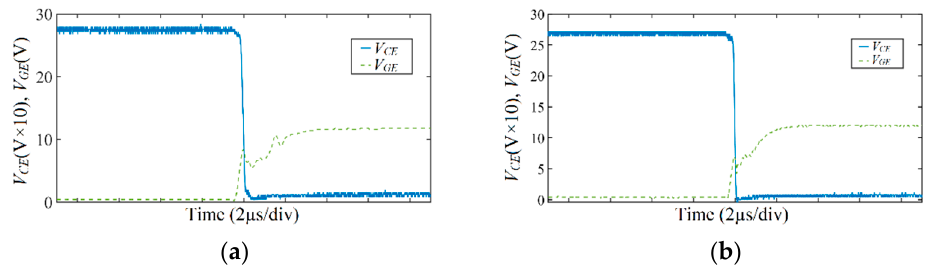
Figure 11. dv / dt influence on the gate voltage: ( a ) During the high-side IGBT turn-on transition; ( b ) During the low-side IGBT turn-on transition.